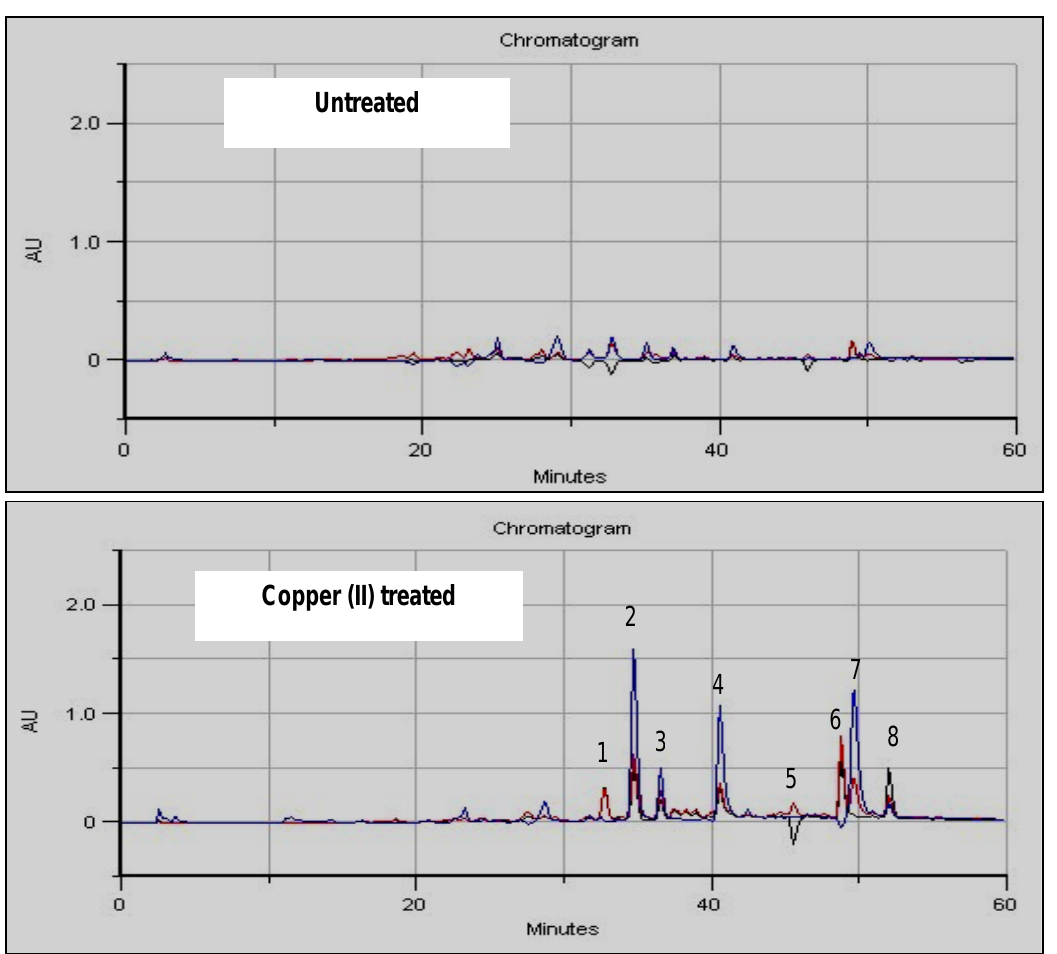
Figure 2. Effect of CuCl